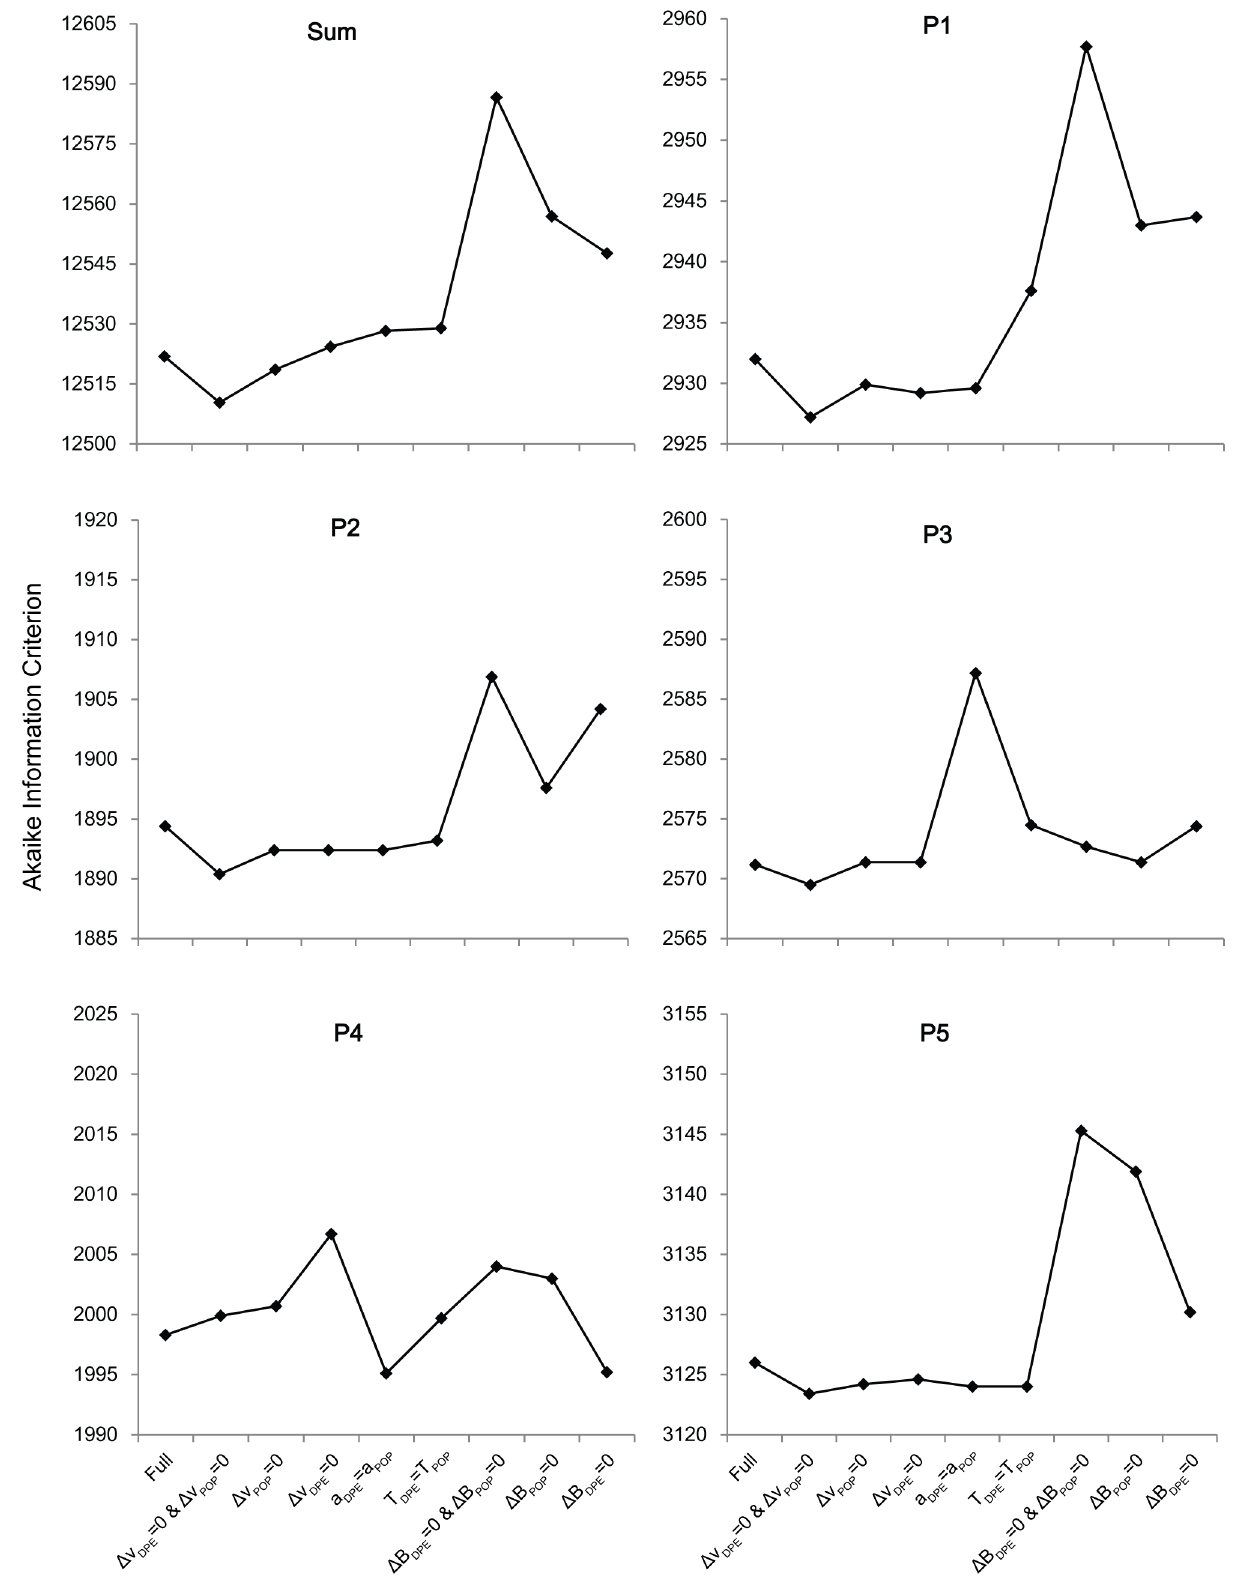
Figure 4. AIC Model Comparison. Akaike information criterion (AIC) values are compared between several sub-models of the RDM. Each sub- model has one or two constrained parameters compared with the full model. This comparison is done for every subject, and the sum of AIC values is used for an across-subjects comparison. Note that AIC biases model selection towards models with more parameters. doi:10.1371/journal.pone.0089996.g004 PLOS ONE |